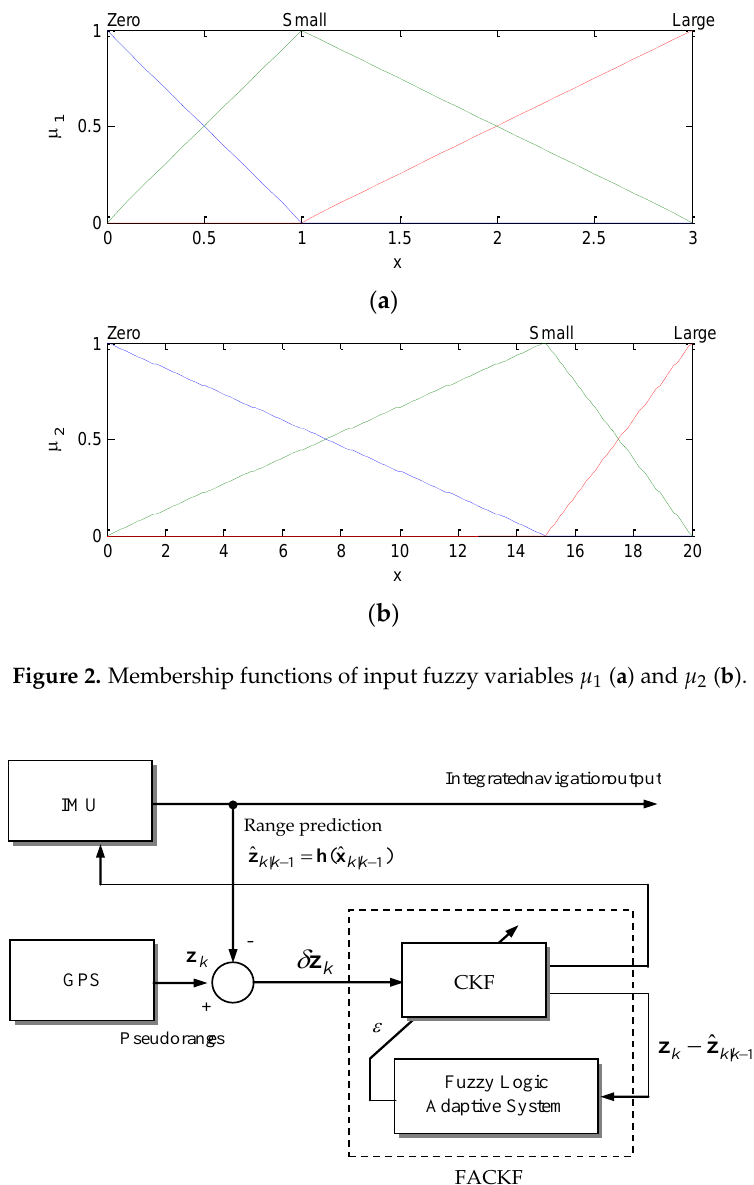
Figure 3. Architecture of the tightly-coupled GPS/INS (Global Positioning System/inertial navigation system) integrated navigation using the FACKF (fuzzy adaptive cubature Kalman filter)-feedback configuration.